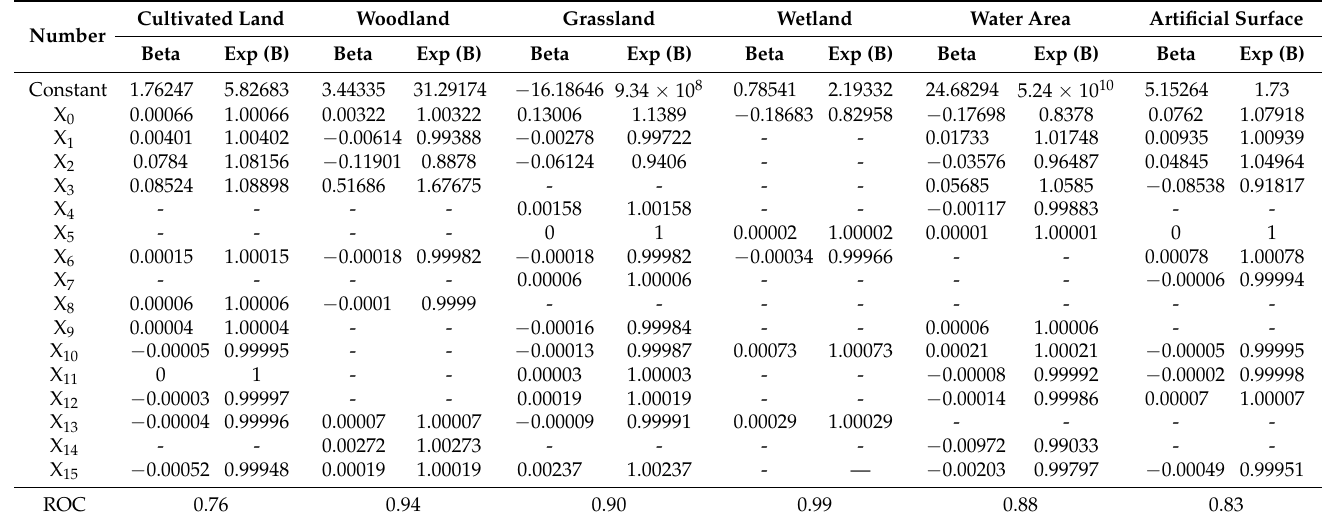
Table 3. Auto-logistic regression analysis.